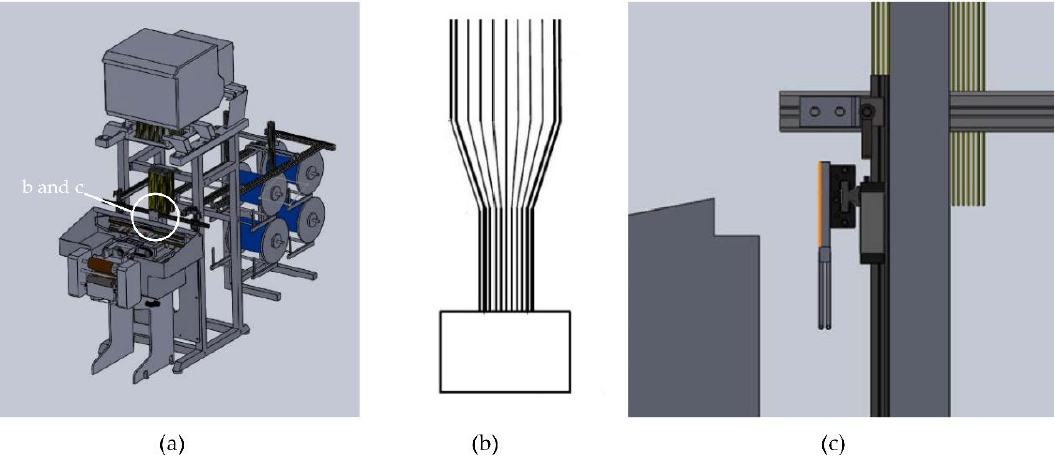
Figure 2. Developed additional ORW device: ( a ) integration into the weaving loom, ( b ) gantry system with ORW needles, ( c ) inserted open weaving reed with variable fabric width.